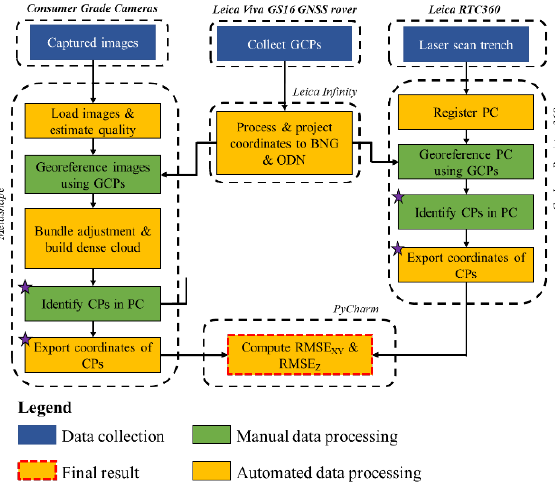
Figure 3 . Workflow for computing locational accuracy.